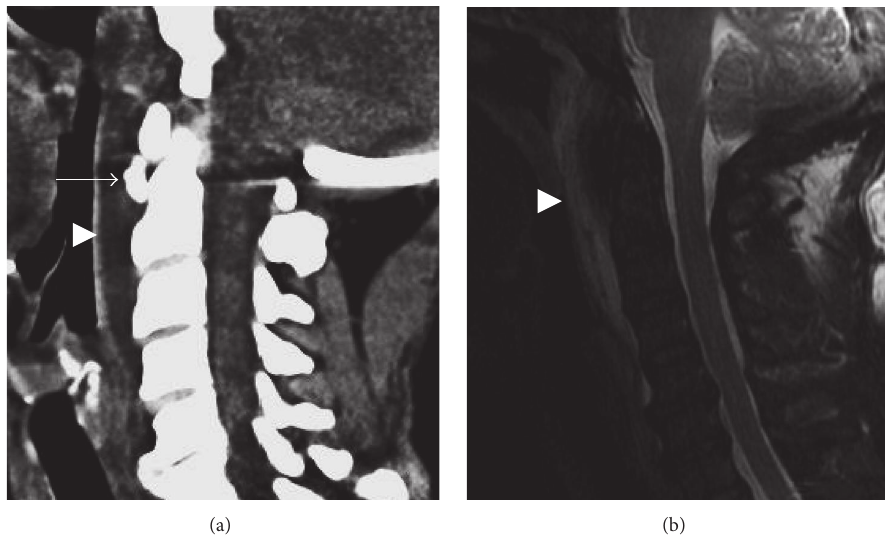
Figure 7: Calcific tendinitis of the longus colli. (a) Sagittal CT showing rounded calcification anterior to the dens just below the C1 anterior arch (arrow). Prevertebral edema causes anterior bowing of the pharyngeal mucosa (arrowhead). (b) Prevertebral edema is more conspicuous on sagittal T2 fat-suppressed image (arrowhead). The calcification of the longus colli tendon is not well appreciated on